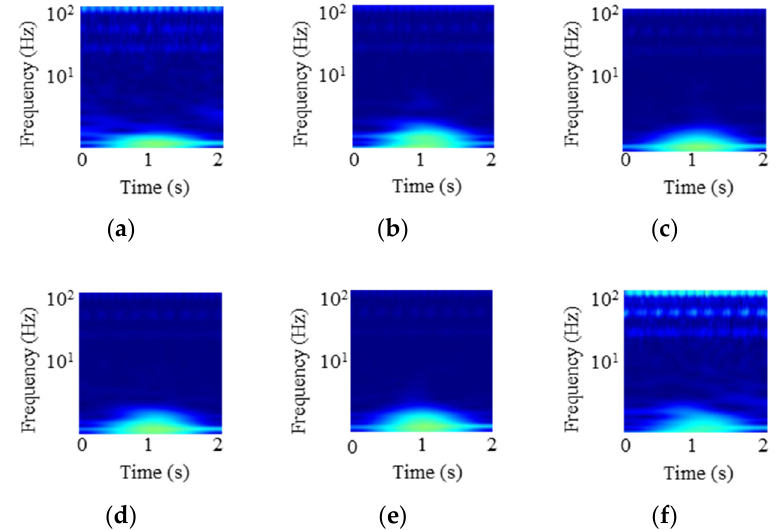
Figure 10. The time-frequency images converted by MFL signals: ( a ) 1 external broken wire; ( b ) 2 external broken wires; ( c ) 3 external broken wires; ( d ) 1 internal broken wire; ( e ) 2 internal broken wires; ( f ) 3 internal broken wires.